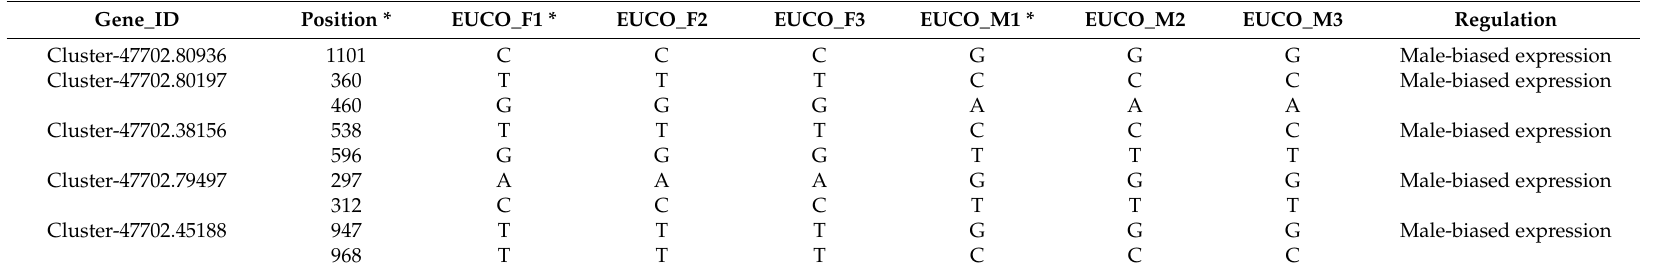
Table 3. Putative sex-associated genes in Eucommia ulmoides .